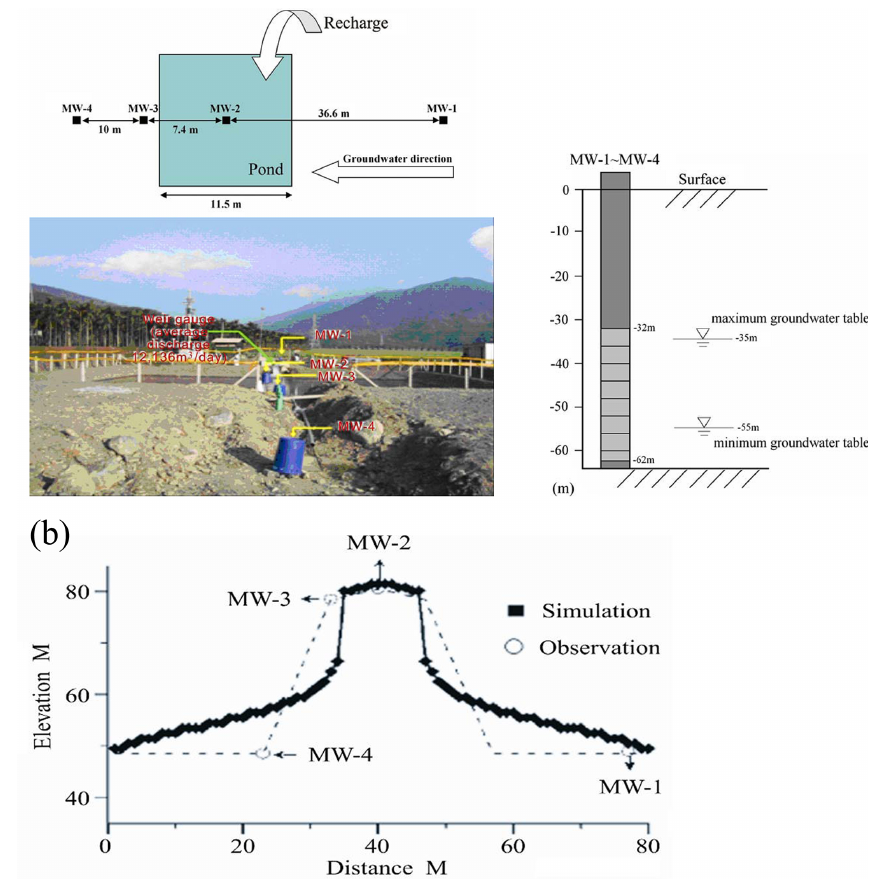
Figure 5. Artificial groundwater recharge using the TOUGH2 model. (a) Infiltration mechanism simulation of artificial groundwater recharge using the TOUGH2 model. (b) Infiltration mechanism simulation of artificial groundwater recharge using the TOUGH2 model.